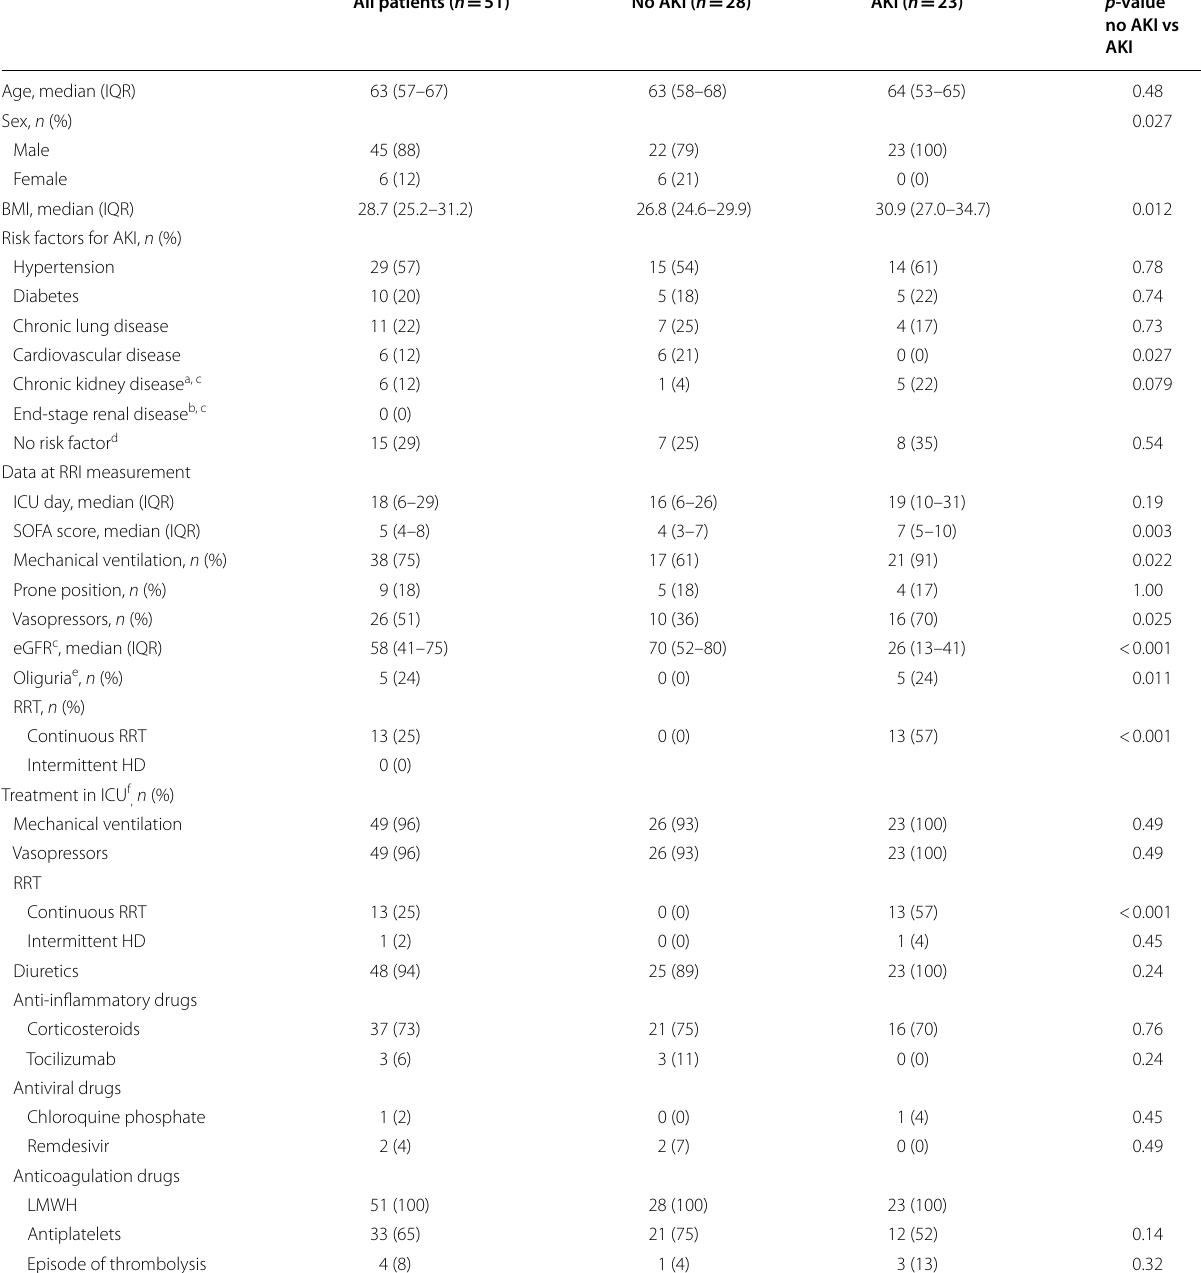
Table 1 Patient characteristics of all patients and those with and without